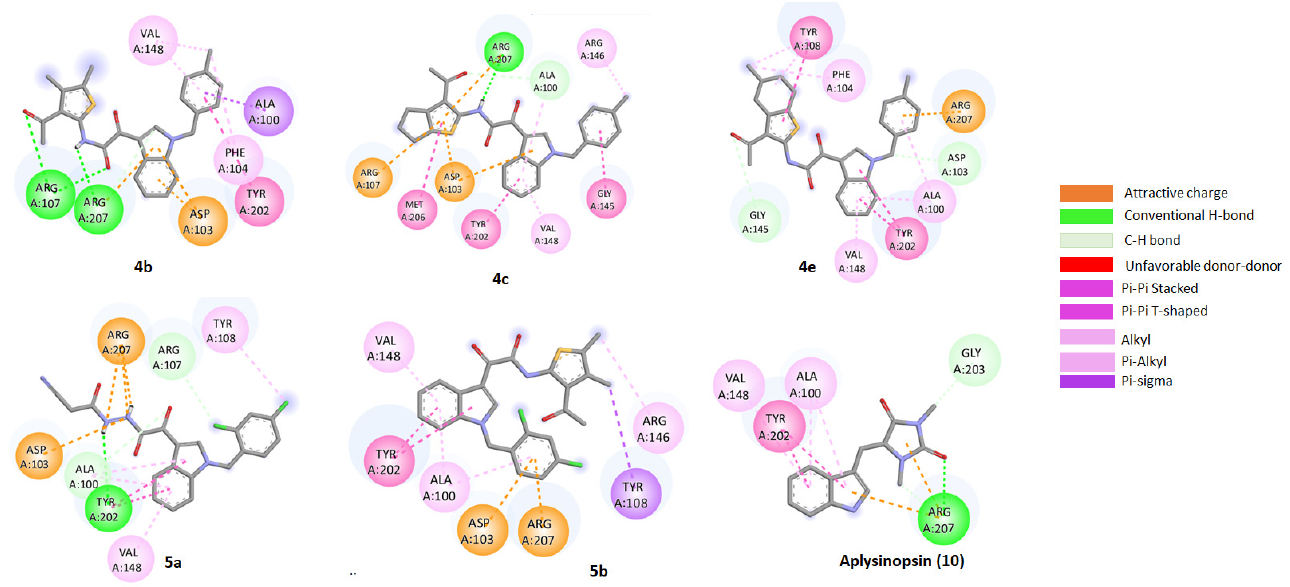
Figure 6. The 2D interaction of aplysinopsin ( 10 ) and its analogs 4b , 4c , 4e , 5a , and 5b within the binding pocket of BCl2 (PDB: 6O0K) illustrating the formed hydrogen bonds, attractive charge, pi-pi bond, and pi-alkyl.